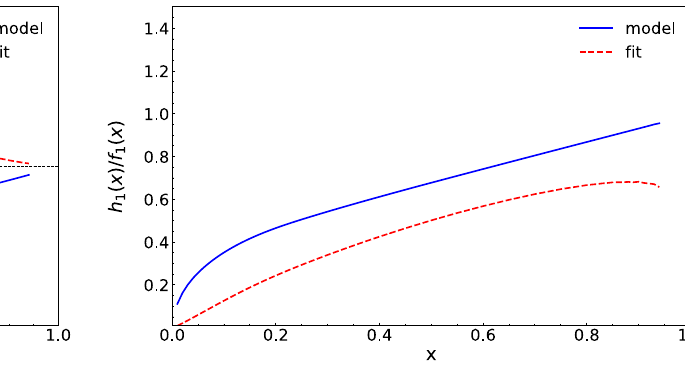
( x )/ f ( x ) for u quark at Q 2 = Fig. 2 Left panel: the ratio h ⊥ ( 2 ) bution [18] and the transversity distribution [19,20] calculated in the 1 1T light-cone SU ( 6 ) quark-diquark model, and the dashed red line corre- 25 GeV 2 . Right panel: the ratio h 1 ( x )/ f 1 ( x ) for u quark at Q 2 = sponds to the first extraction of the pretzelosity distribution ( h ⊥ 25 GeV 2 . The solid blue line corresponds to the pretzelosity distri- and the recent transversity distribution parametrizations [22]